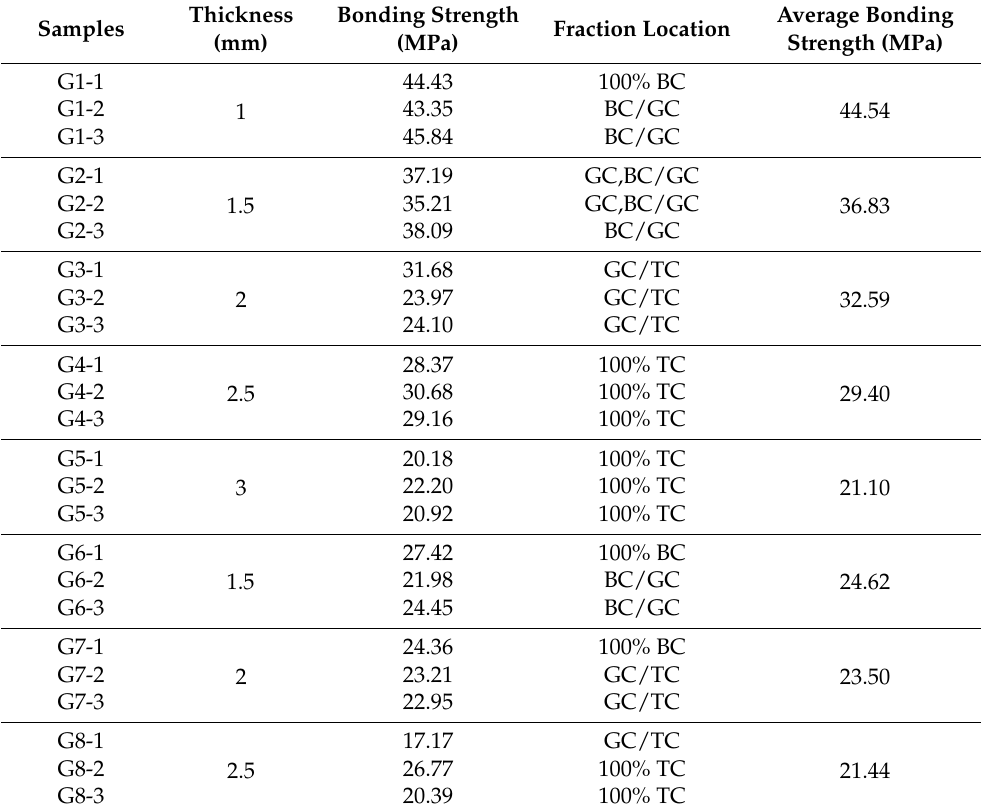
Table 2. Bonding strength and fraction location of samples with millimeter level